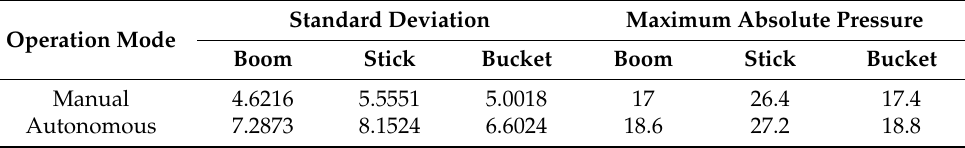
Figure 9. A comparison of autonomous and manual excavation cylinder pressure. The blue curve is autonomous excavation and the red curve is manual excavation. autonomous excavation and the red curve is manual excavation. Table 4. Comparison of manual and autonomous excavation cylinder pressure. Table 4. Comparison of manual and autonomous excavation cylinder